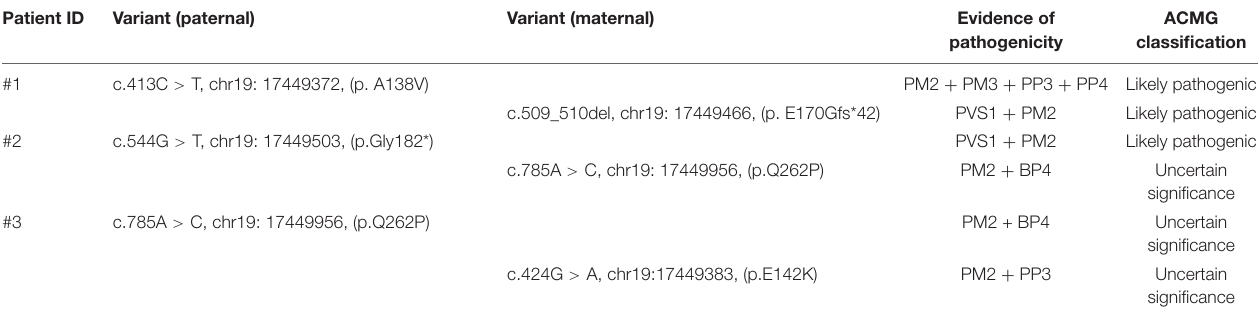
TABLE 1 | The molecular genetics analysis of three